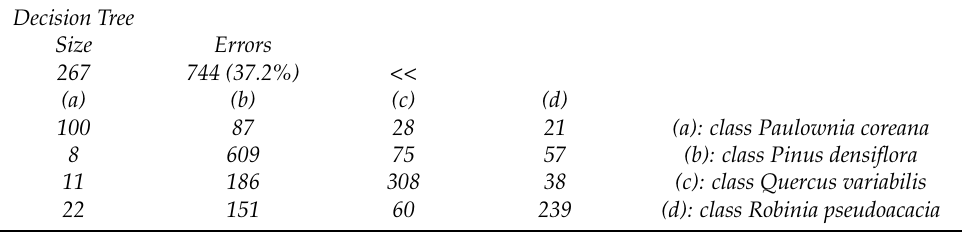
Table 3. Confusion matrix of the species model.